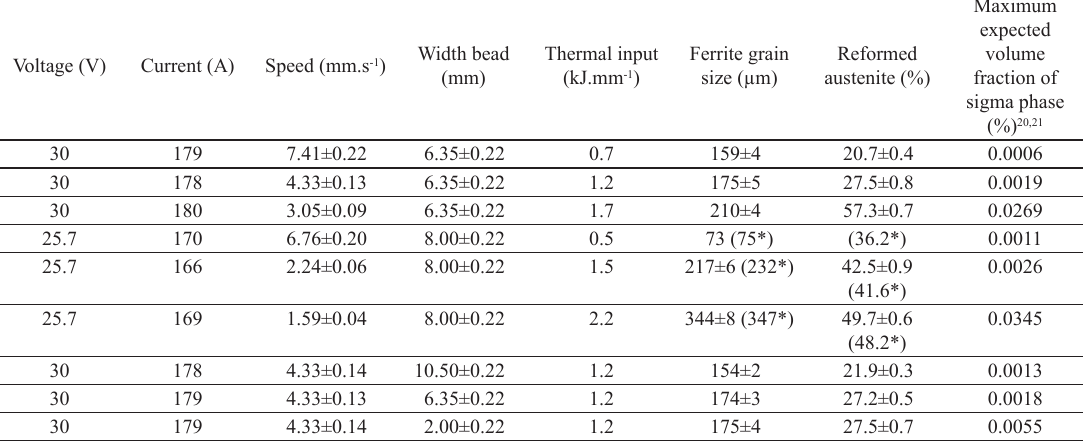
Voltage (V) Current